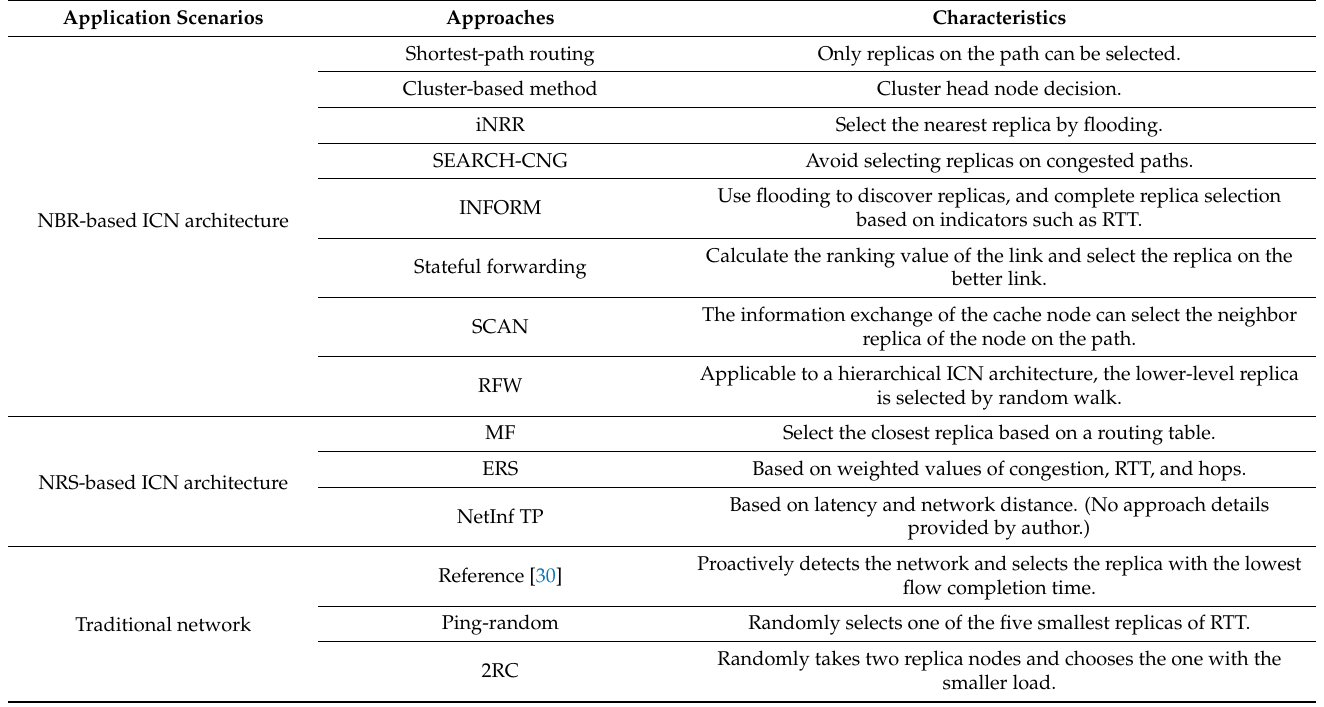
Table 1. Characteristics of the related